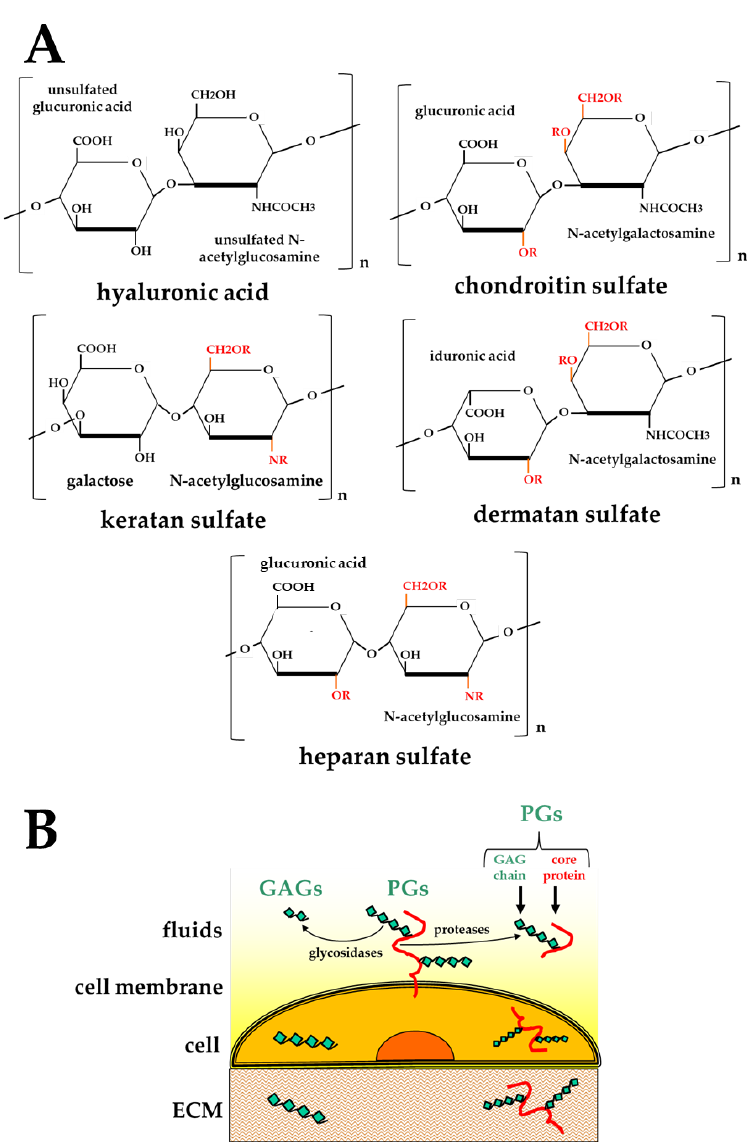
Figure 1. ( A ) Chemical structures of the disaccharide units composing the five main classes of GAGs. In red, “R” indicates potential points of sulfation. ( B ) Schematic representation of the distribution of GAGs/PGs inside the cell, on its surface, in the ECM or in body fluids.